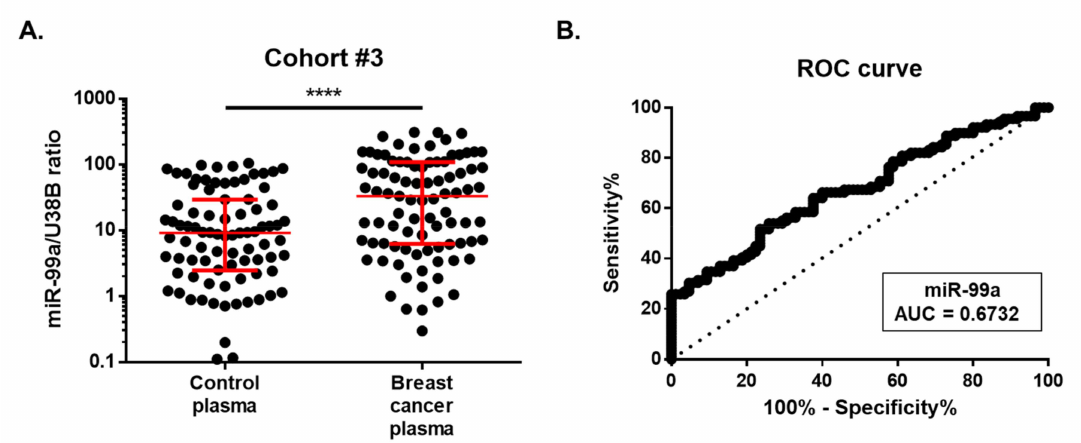
Figure 4. ( A ) Circulating miR-99a levels in cohort #3. Di ff erential miR-99a levels in plasma of 89 breast cancer patients were compared with those of 85 healthy controls. Expression levels were significantly lower in healthy controls than in breast cancer patients. Red horizontal line: median with interquartile range. Mann–Whitney U, **** p < 0.0001. ( B ) Receiver-operating characteristic (ROC) curve analysis for circulating miR-99a levels in cohort